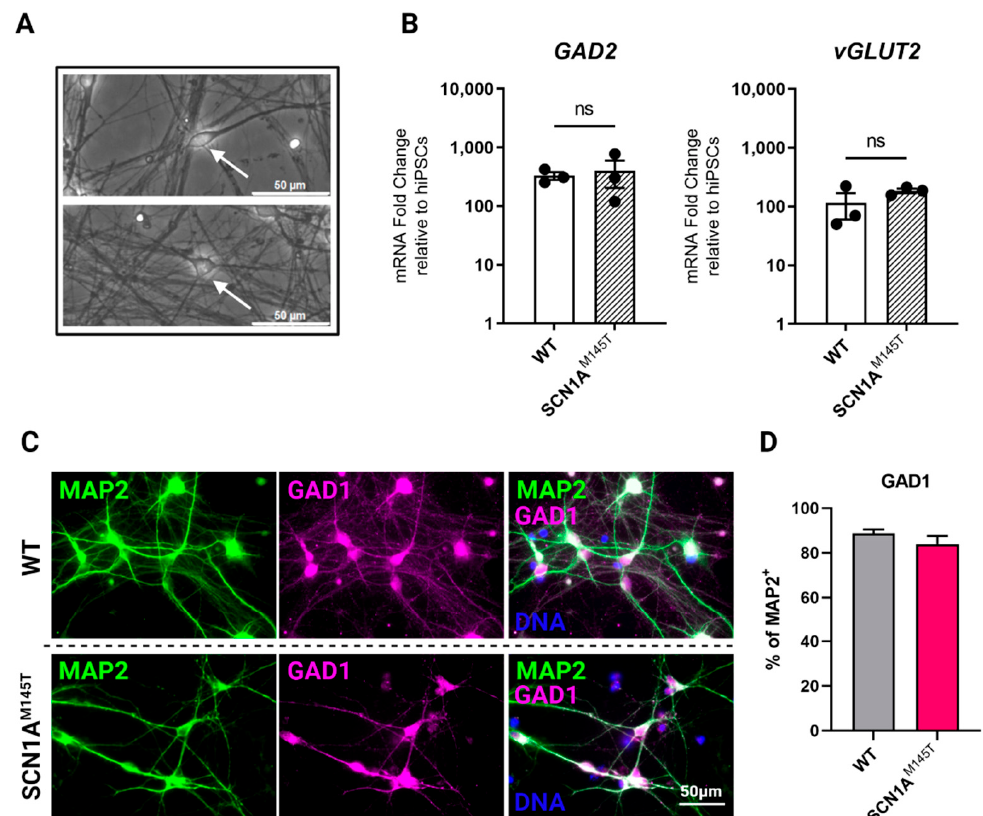
Figure 2. Expression of GABAergic and glutamatergic markers in idNs. ( A ) Generated idNs are composed of a mixed neuronal population containing neurons with both bipolar (upper panel, white arrow) and pyramidal (lower panel, white arrow) morphology. ( B ) Expression analysis of mRNAs relative to GABAergic (inhibitory) marker glutamate decarboxylase 2 ( GAD2 ) and glutamatergic (excitatory) marker vesicular glutamate transporter 2 ( vGLUT2 ) in idNs relative to undifferentiated iPSCs. GAPDH was used as a housekeeping gene. qRT-PCR analysis did not reveal significant differences in the expression of GAD2 and vGLUT2 between diseased and control idNs relatively to their undifferentiated iPSCs ( p -value = non-significant (ns), t -test), even though a higher prevalence of GABAergic marker GAD2 was detected, as shown by its higher fold change relative to iPSCs. Data are presented as mean ± SEM of three biological replicates (dots). ( C ) Representative immunoflu- orescence images of GABA synthesis enzyme GAD1 compared to neuronal marker MAP2 in idNs of WT (upper line images) and SCN1A M145T (lower line images) cells (63 × magnification). ( D ) The diagram shows that about 90% of MAP2 + cells co-express the GAD1 marker. For each cell line, at least 300 neurons were counted, and data are presented as mean ± SEM of two independent experiments.